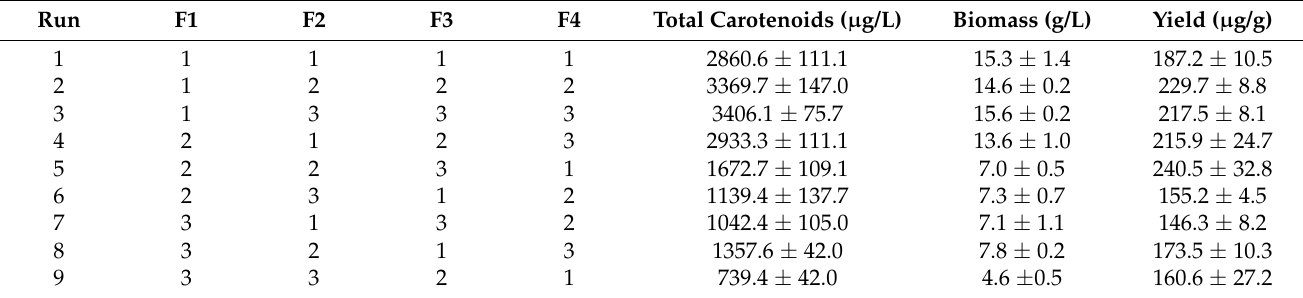
Table 2. Taguchi L9 orthogonal array and total carotenoid, biomass, and yield results at each